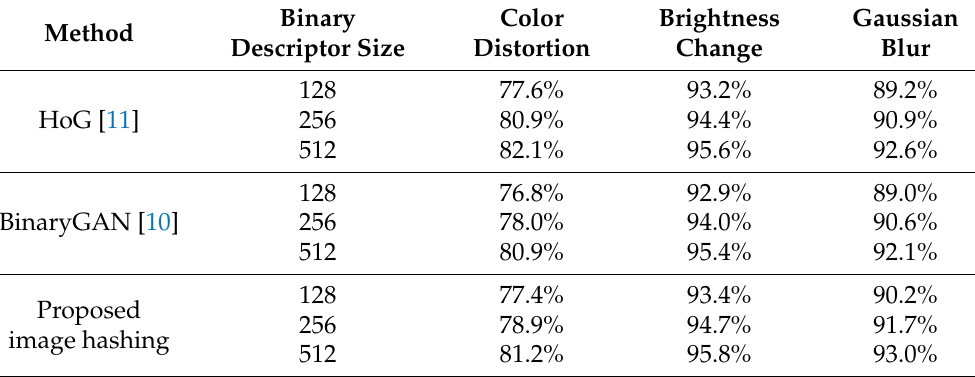
Table 3. Identification results on the copyright image dataset by applying the HoG, the BinaryGAN and the proposed method with various color manipulations and descriptor